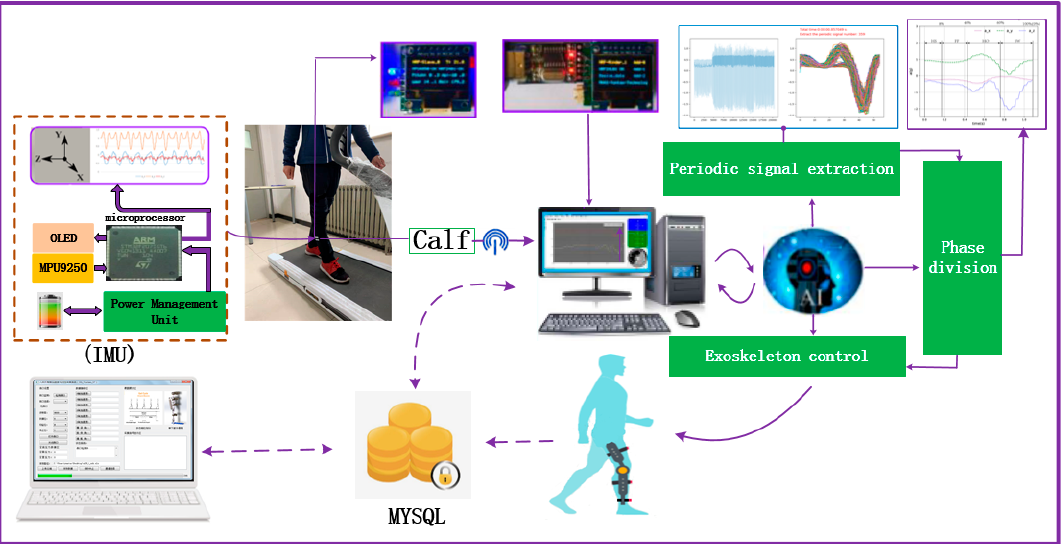
Figure 3. Human gait-information acquisition system.